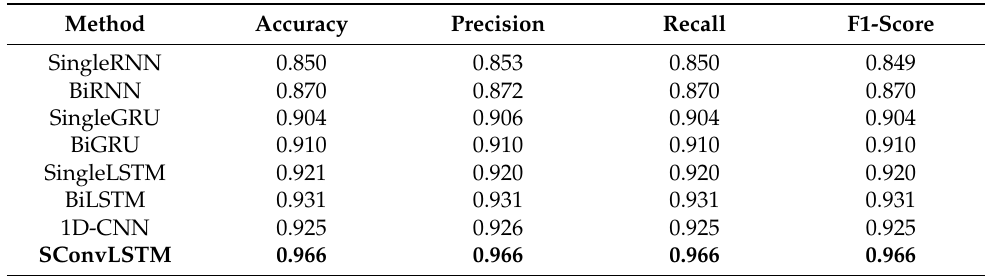
Table 3. Classification performance of proposed method and some based on deep learning methods on UCI-HAR dataset.